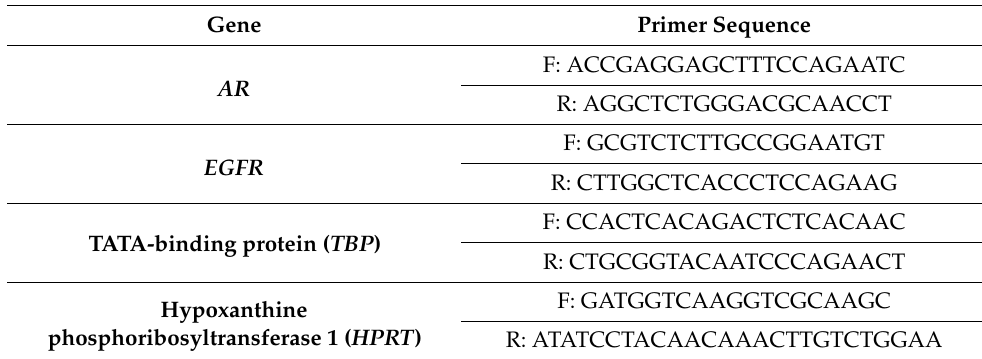
Table 3. The primers that were used to study the expression of the specified